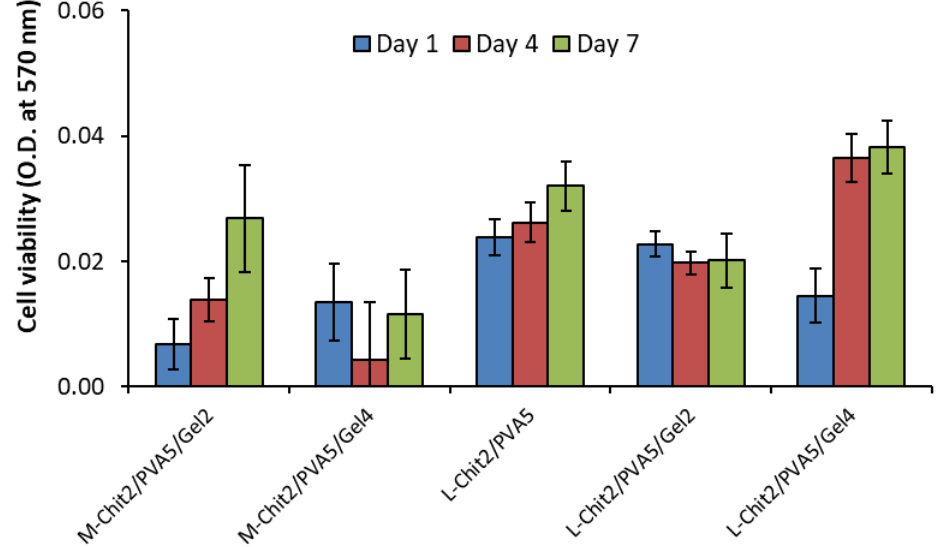
Figure 6. Cellular viability of HFFF2 growing on irradiated (10 kGy) medium and low Mw chitosan-based membranes with and without gelatin, in culture days 1, 4, and 7 (n = 3; mean value ± SD).